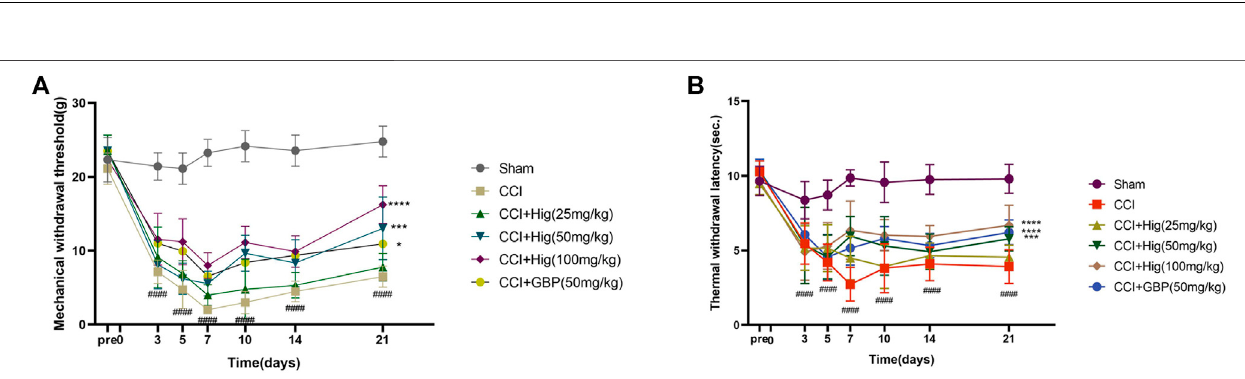
FIGURE5| Hig relieved mechanical allodynia and heat hyperalgesia in CCI rats by raising the thresholds of MWT and TWI. (A) The value of MWT in each group was detected by the von Frey test on the day before the surgery and days 3, 5, 7, 10, 14, and 21 after surgery. (B) The value of TWI in each group was detected by the hot-plate test. The results are presented as mean ± SEM, n (cid:2) 8. #### p < 0.0001 vs. the control group. * p < 0.05, *** p < 0.001, and **** p < 0.0001 vs. the CCI group.